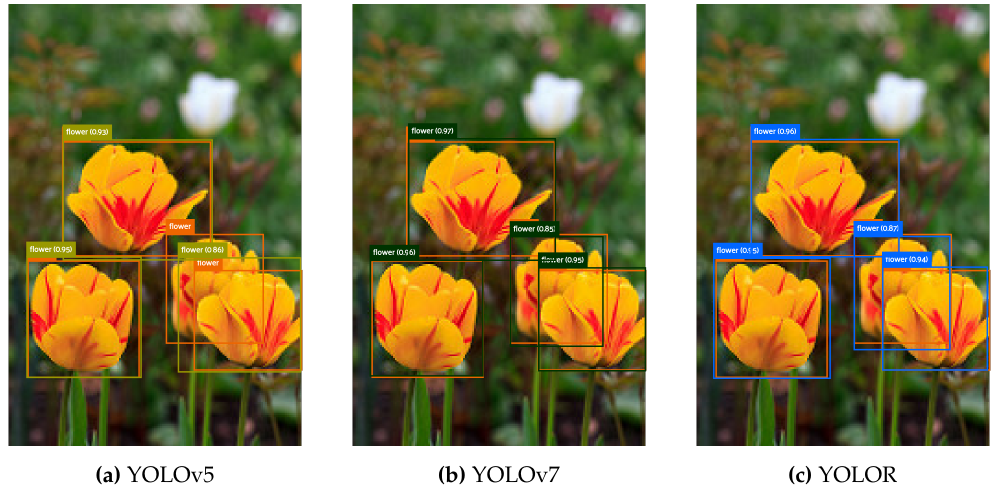
Figure 8. Detection of flowers in samples from the test set of the TensorFlow Flower Detection Dataset. Orange bounding boxes present ground truth. ( a ) Light-green bounding boxes indicate the predictions from YOLOv5. ( b ) Dark-green bounding boxes indicate the predictions from YOLOv7. ( c ) Blue bounding boxes indicate the predictions from